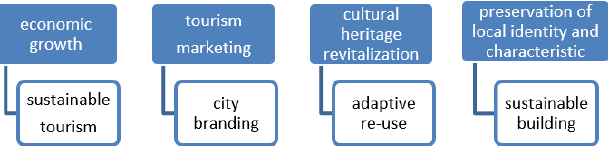
Table 1 . Theories of Revitalization and Adaptive Re-use in Sustainable Tourism and Building (Developed by